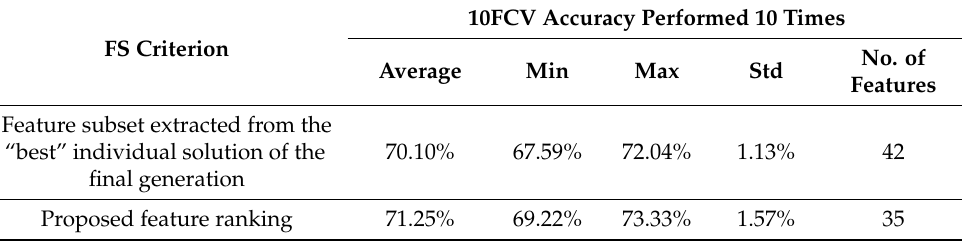
Figure 6. Feature ranking produced by the proposed FS (the dashed line indicates the number of features that were finally selected). Table 3. Comparative analysis with respect to the final selection of features: proposed feature ranking versus the feature subset of the best individual solution in the final